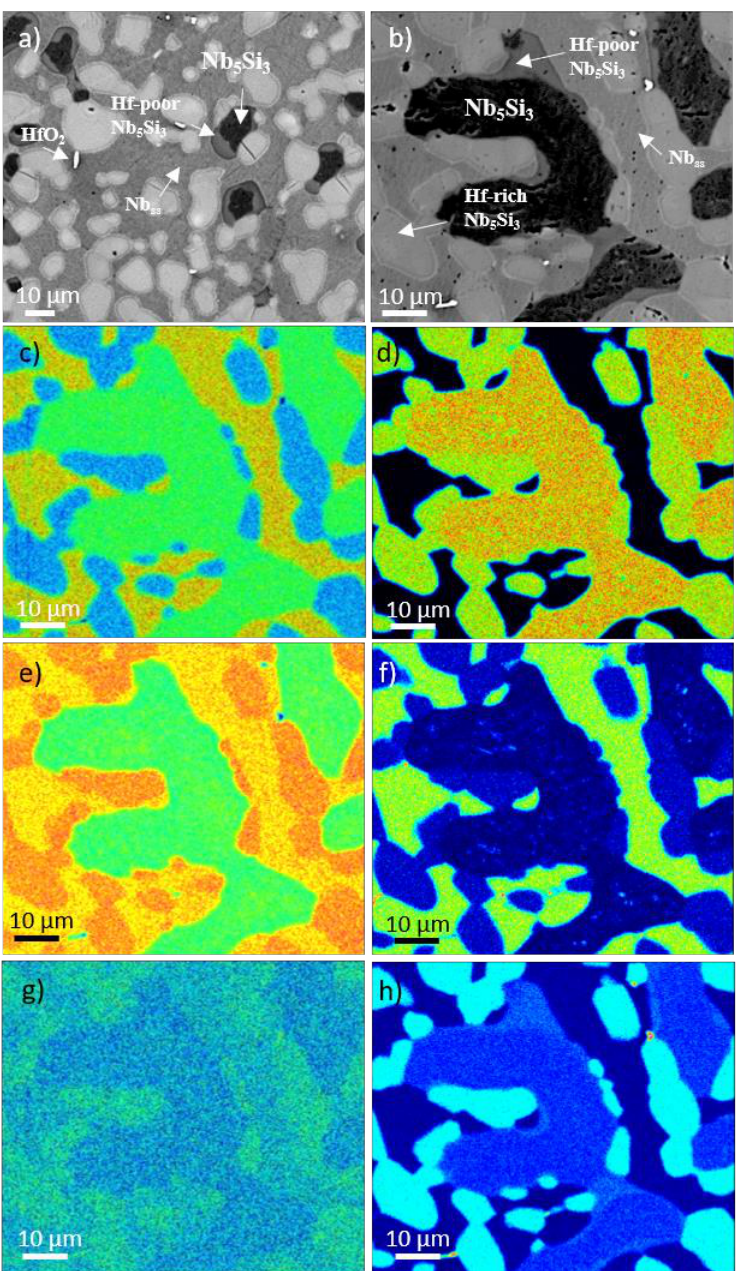
Figure 2. BSE images ( a ) and ( b ) of the heat treated microstructure of the alloy NbSiTiHf-5Al-5Cr and EPMA X-ray maps corresponding to ( b ) of ( c ) Nb, ( d ) Si, ( e ) Ti, ( f ) Cr, ( g ) Al and ( h ) Hf.